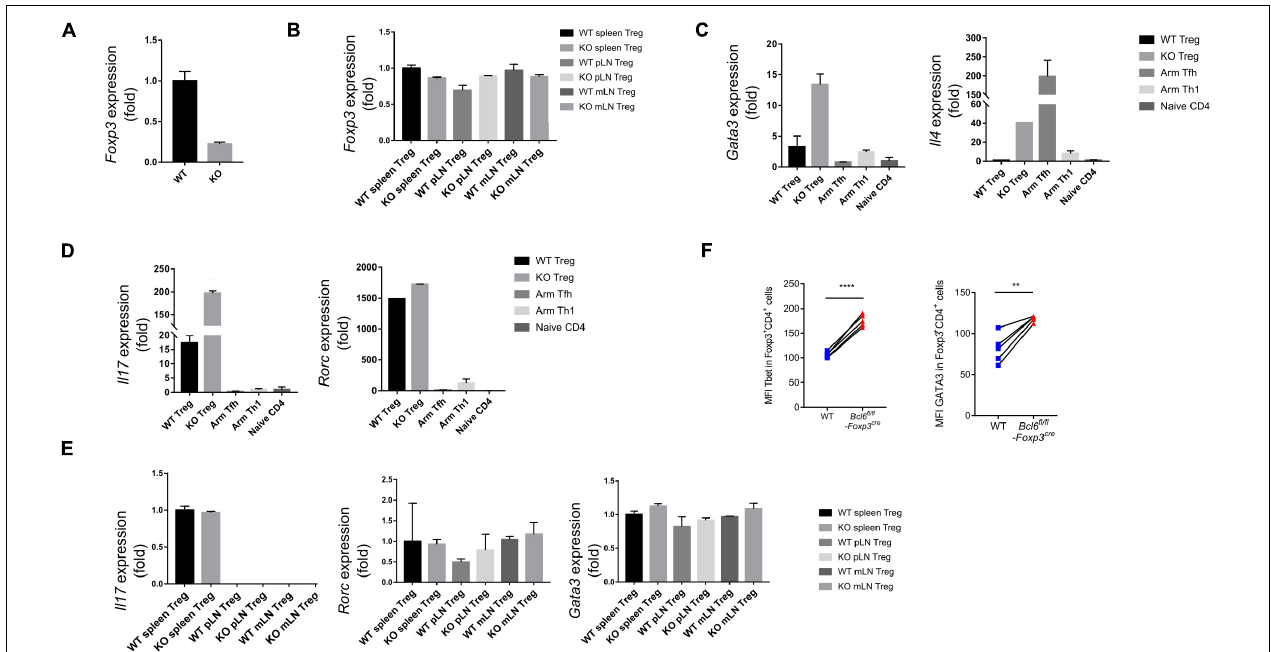
FIGURE 4 | Bcl6 is essential in maintaining the lineage stability of Treg cells in TME. (A) RT-qPCR analysis of Foxp3 expression, normalized to its expression in Bcl6-deficient tumor infiltrating Treg cells (CD4 + CD25 + GITR + CXCR5 − ), assessed at day 16 after B16-F10 inoculation intravenously. (B) RT-qPCR analysis of Foxp3 expression, normalized to its expression in Treg cells (CD4 + CD25 + GITR + CXCR5 − ) from spleen, mesenteric lymph nodes(mLN) or peripheral non-draining lymph nodes (pLN) of naive Bcl6 fl / fl Foxp3 Cre and WT mice. (C,D) RT-qPCR analysis of Gata3 and Il4 (C) , Il17 and Rorc (D) normalized to their expression in Bcl6-deficient and WT tumor infiltrating Treg cells (CD4 + CD25 + GITR + CXCR5 − ). Naive CD4 (gated in CD4 + CD44 − ) sorted from naive WT mice, Tfh (gated in CD4 + CD44 + Foxp3 − CXCR5 + ) and Th1 (gated in CD4 + CD44 + Foxp3 − CXCR5 − ) cells sorted from WT mice infected with Armstrong (Arm) at day 8 are included as control. (E) RT-qPCR analysis of Il17 , Rorc and Gata3 normalized to their expression in Treg cells (CD4 + CD25 + GITR + CXCR5 − ) from spleen, mesenteric lymph nodes(mLN) or peripheral non-draining lymph nodes (pLN) of naive Bcl6 fl / fl Foxp3 Cre and WT mice. The data (A-E) presented are representative of two technical replicates pooled from at least three mice per group. Error bars indicate the mean ± SEM. (F) Flow cytometry analysis of tumor infiltrating Treg cells in splenic chimera mice assay, assessed at day 18 after B16-F10 inoculation intravenously. Quantification of Tbet and GATA3 in Bcl6-deficient and WT Treg cells. The data presented are representative of two independent experiments with at least 4 mice per group. Statistical differences were calculated by paired t -test. ** p < 0.01, **** p <